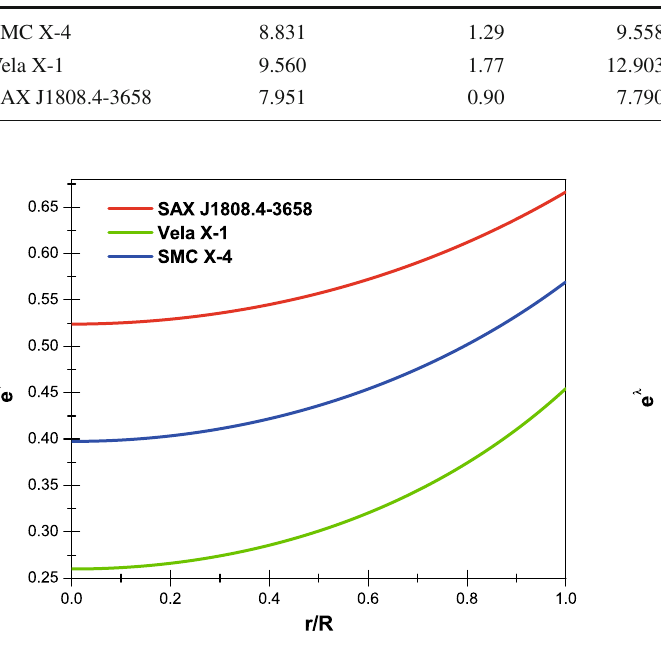
Fig. 4 The deformed radial metric component versus the dimension- less radius for α = 0 .